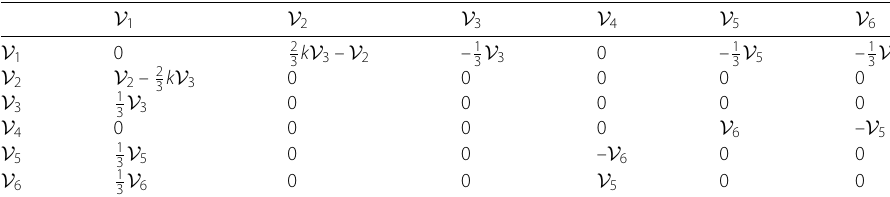
Table 1 Commutation relation of the Lie algebra of Eq. (2)